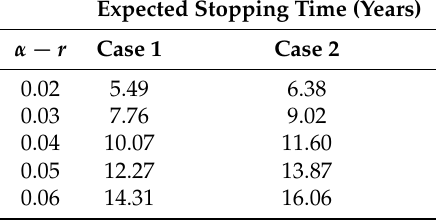
Table 3. Expected stopping times by level of equity premium for case 1 and case 2 agents aged 65, in the healthy state, and with total wealth of 10 Y —and other parameters as given in Table 1. Increasing the equity premium results in longer stopping times, as agents exploit the more profitable investment environment. The situation illustrated is for agents with risk aversion of γ = − 0.5, where case 2 agents are less conservative than case 1 agents. With more risk averse agents, this boldness of agents with bequest motives over those without is